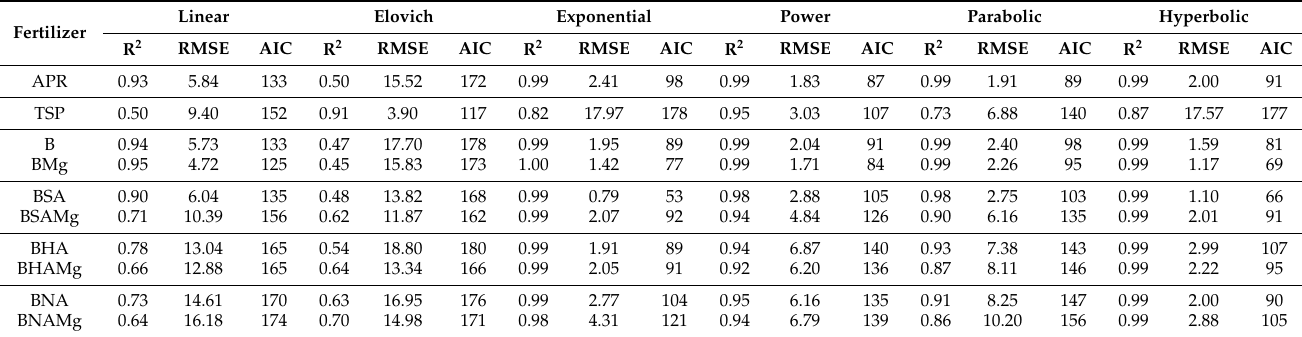
Table A4. Coefficients of the kinetics of P release in citric acid at 2% for each fertilizer